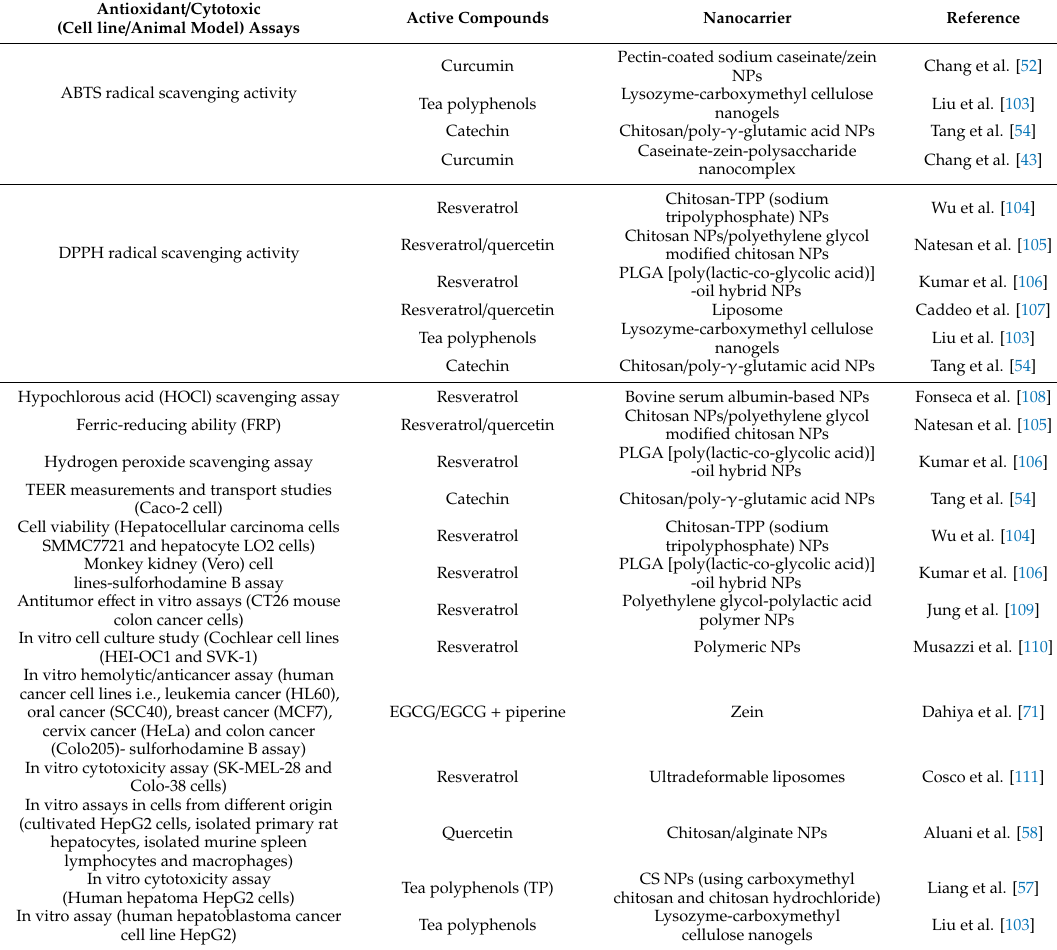
Table 2. Methods used for determination of the biological properties of polyphenol-loaded nanoparticles. Antioxidant / Cytotoxic (Cell line / Animal Model) Assays Active Compounds Nanocarrier